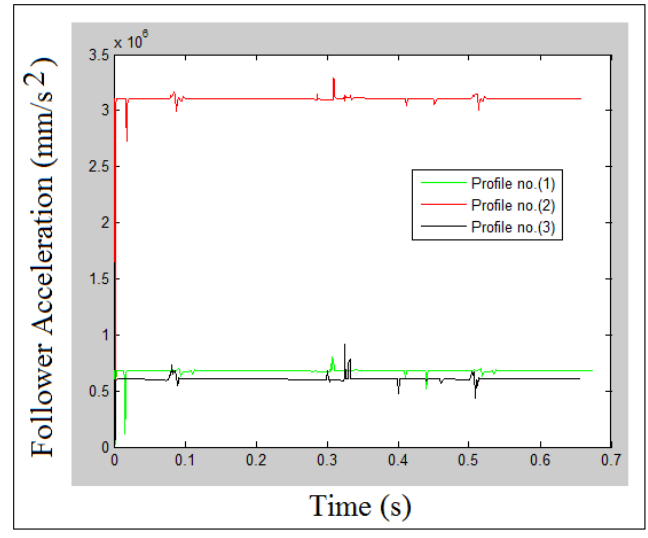
Figure 6. Acceleration against time for the three involutes’ profiles of the cam.